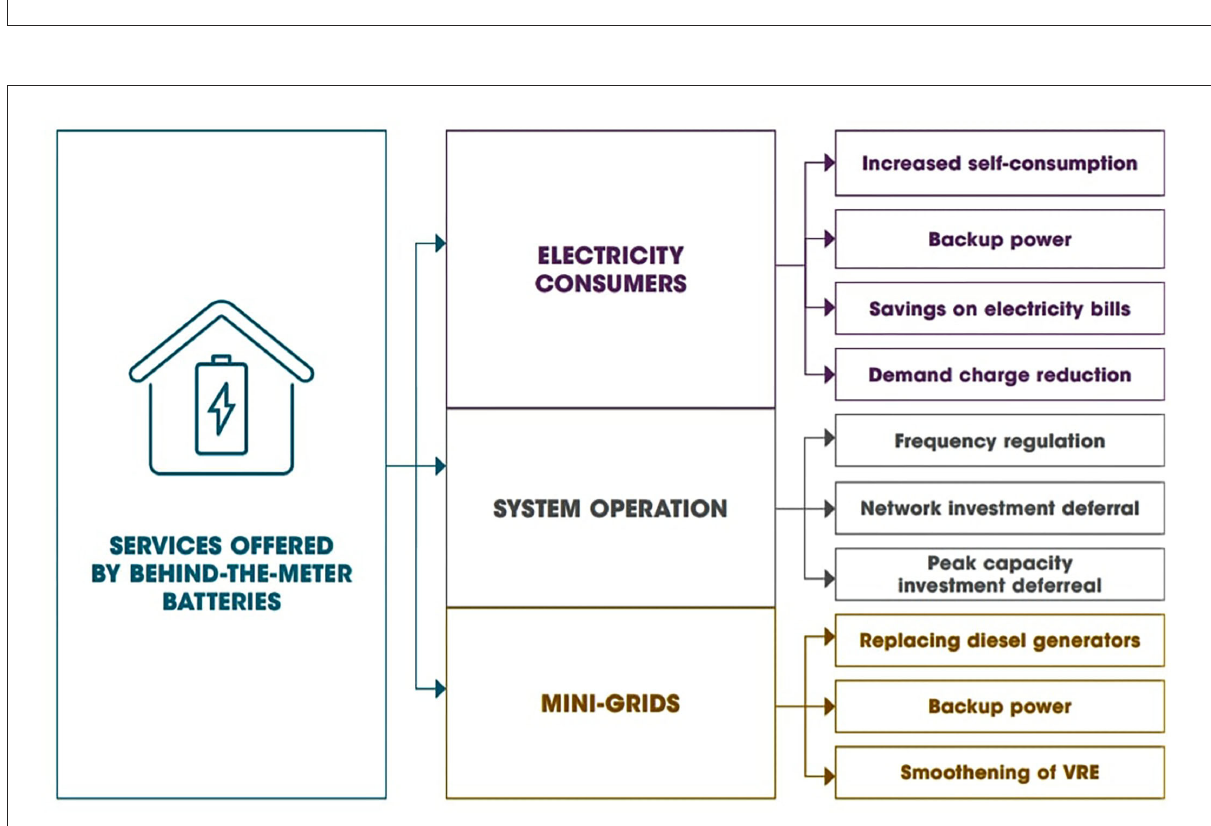
FIGURE7 Services offer by behind the meter batteries ( Irena,